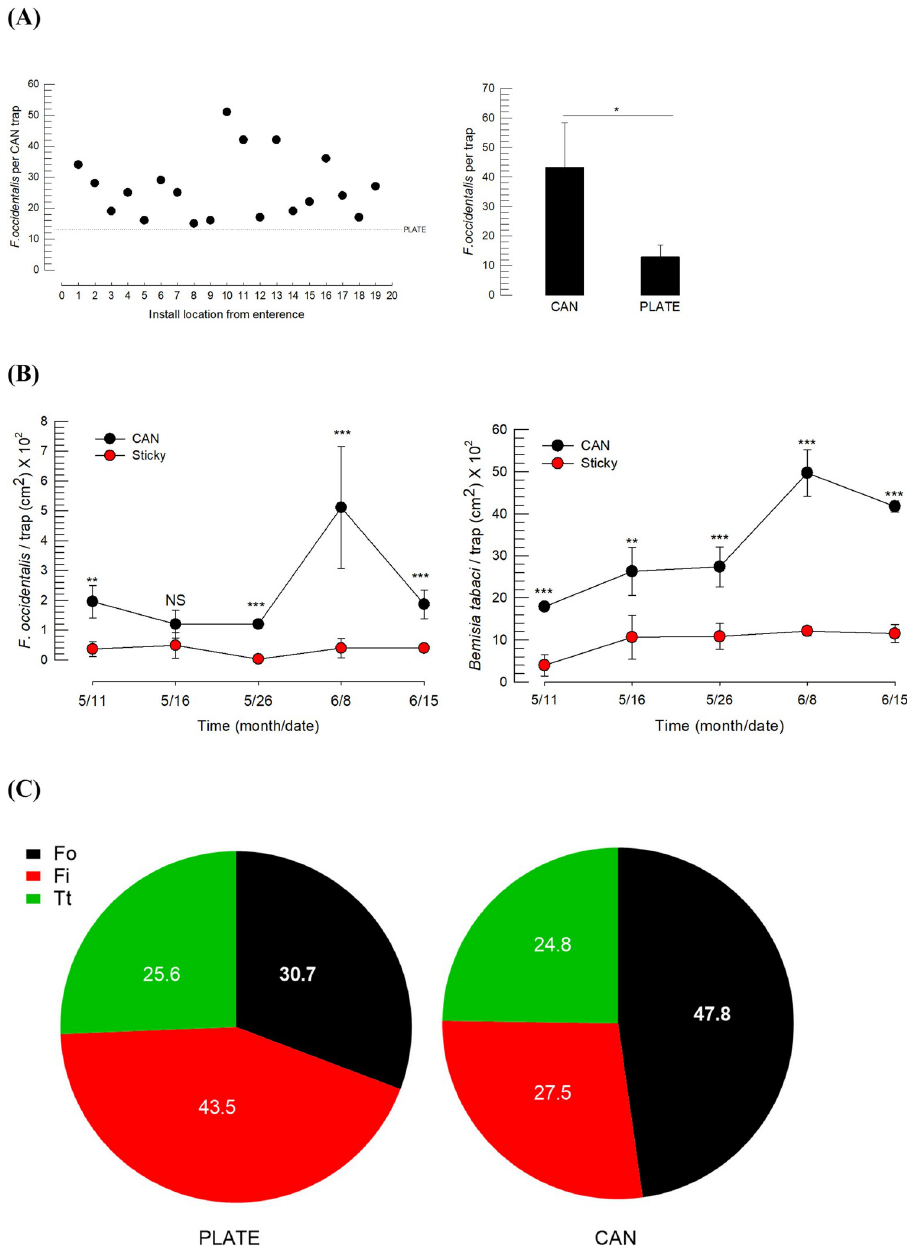
Fig 3. Field efficacy of a yellow CAN trap containing aggregation pheromone. (A) Enhanced trapping efficiency of the CAN trap containing aggregation pheromone compared to the yellow sticky plate (PLATE). CAN and PLATE traps used 20 and three replications, respectively. An asterisk above the standard deviation bars indicates a significant difference between two treatments at type I error = 0.05 (LSD test). (B) Enhanced pulling effect of the CAN trap on trapping F . occidentalis and B . tabaci in different seasons. Two and three asterisks above the standard deviation bars indicate significant differences between two treatments at Type I error = 0.01 and type I error = 0.0001 (LSD test), respectively. NS indicates no significant difference. (C) Composition of thrips trapped by the PLATE and CAN traps. The average species frequencies in CAN and PLATE traps were obtained from 20 and three replications, respectively. The repellent efficacy of the wax formulation was maintained for four weeks without signifi- cant ( F = 1,600.00, df = 4, 10; P = 0.0001) differences in the greenhouse conditions.